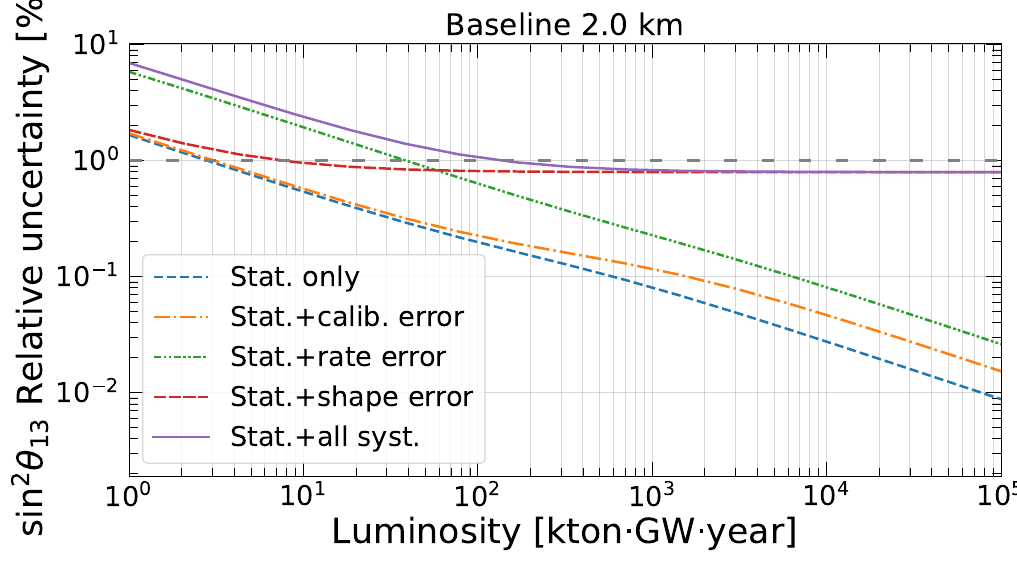
Figure 5 . The sin 2 θ 13 precision measurement sensitivity under different considerations of the systematic uncertainties as a function of integrated luminosity. The rate uncertainty is the dominant systematics at low statistics for the single detector strategy. With the integrated luminosity larger than ∼ 60 kton · GW · year , the shape uncertainty gradually dominates the precision measurement of sin 2 θ 13 . The ultimate precision sensitivity is approximately 0.8%, limited by the spectral shape